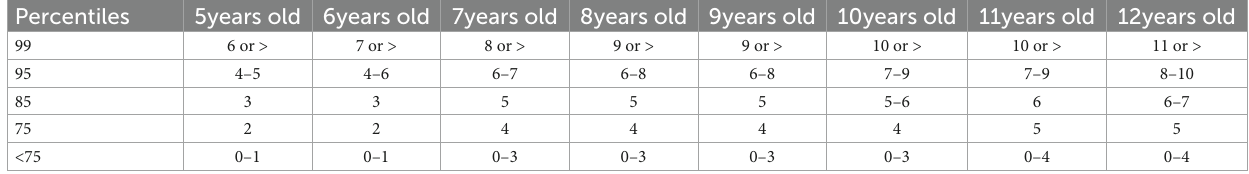
TABLE 1 Conversion of directs scores form the T2F-E test to percentiles according to age (Maganto and Garaigordobil, 2009b).